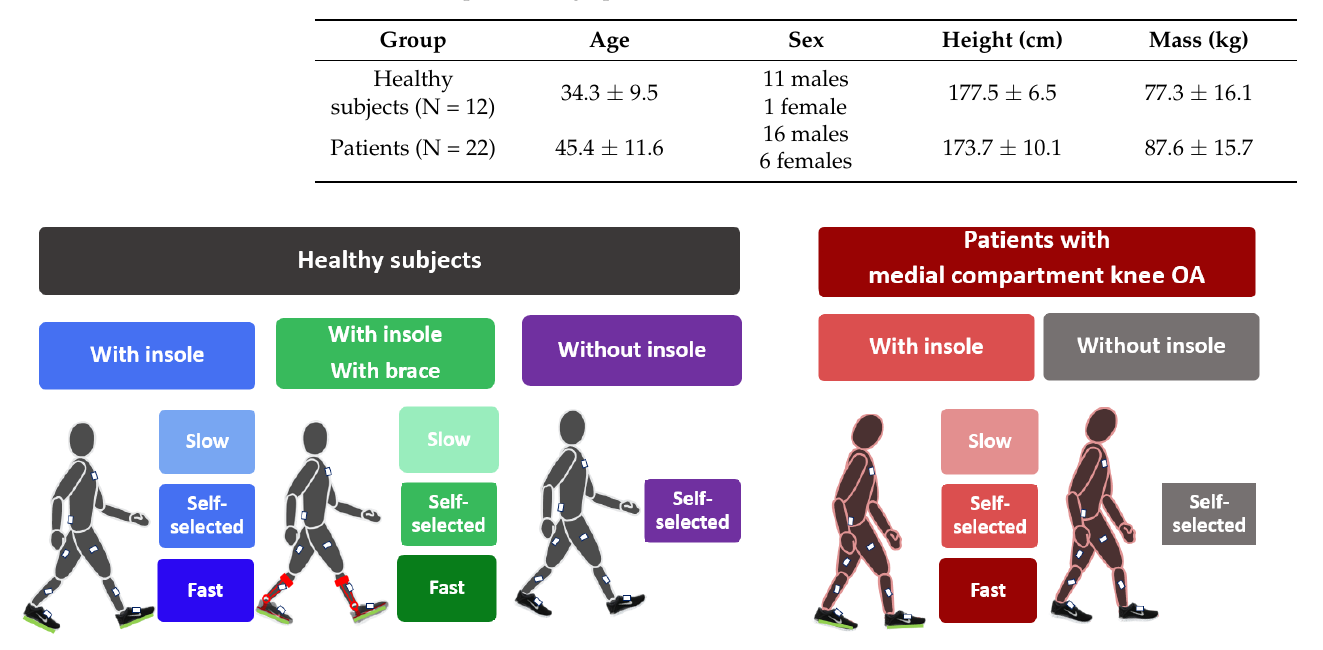
Figure 1. Graphical summary of the experimental protocol, including healthy subjects and patients. All subjects walked at three speed levels: self-selected, slow, and fast while wearing an instrumented insole. All subjects also walked at self-selected speed after removing the insole. To investigate the deviated gait pattern, healthy subjects walked with the brace at three speed levels. OA: osteoarthritis. In order to simulate abnormal gait patterns and to consider the effect of instruments on gait, healthy subjects repeated the test while wearing an ankle–foot orthosis (Agilium Freestep, Ottobock, Duderstadt, Germany) that decreased the foot progression angle [24] and tibia varus [25]. For each condition (i.e., with/without brace or insole) and each gait speed (slow, self-selected, and fast), six straight walking bouts with minimum two gait cycles were captured. Written informed consent was obtained from all participants, and the study was approved by the local ethics committee (CER-VD protocol